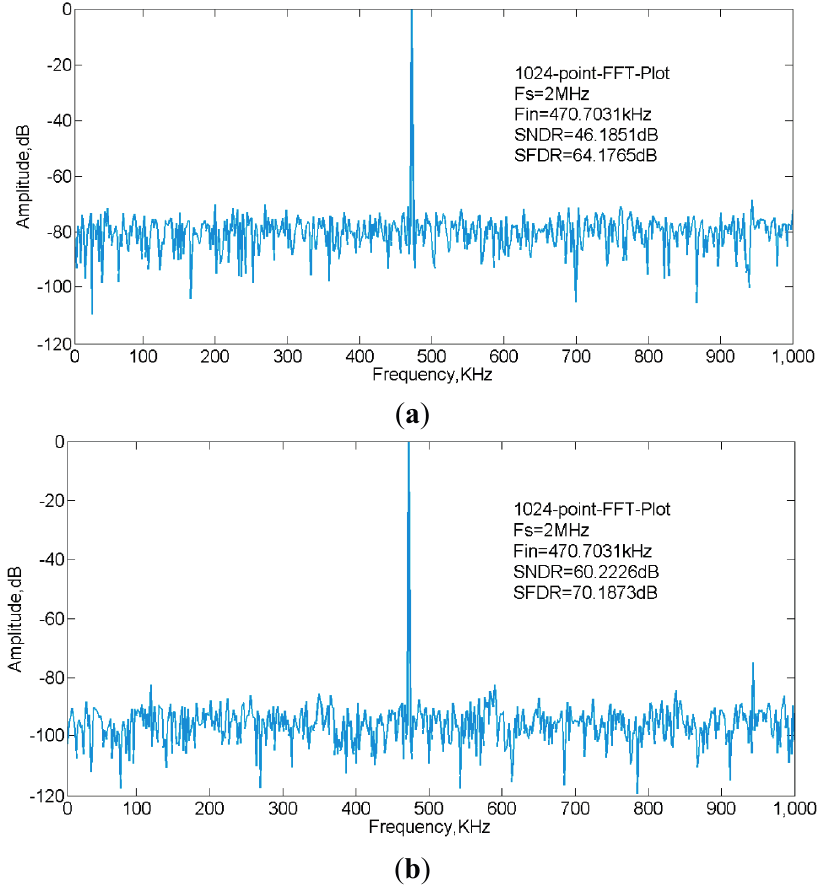
Figure 17. ADC output spectrum. ( a ) Without calibration; ( b ) With calibration.